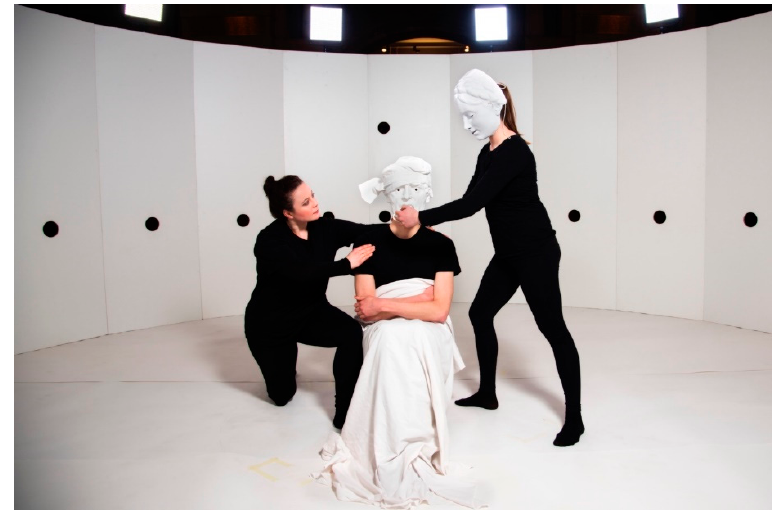
Figure 2. Christine Borland, Photosculpture, 2018. Image Courtesy of Christine Borland.